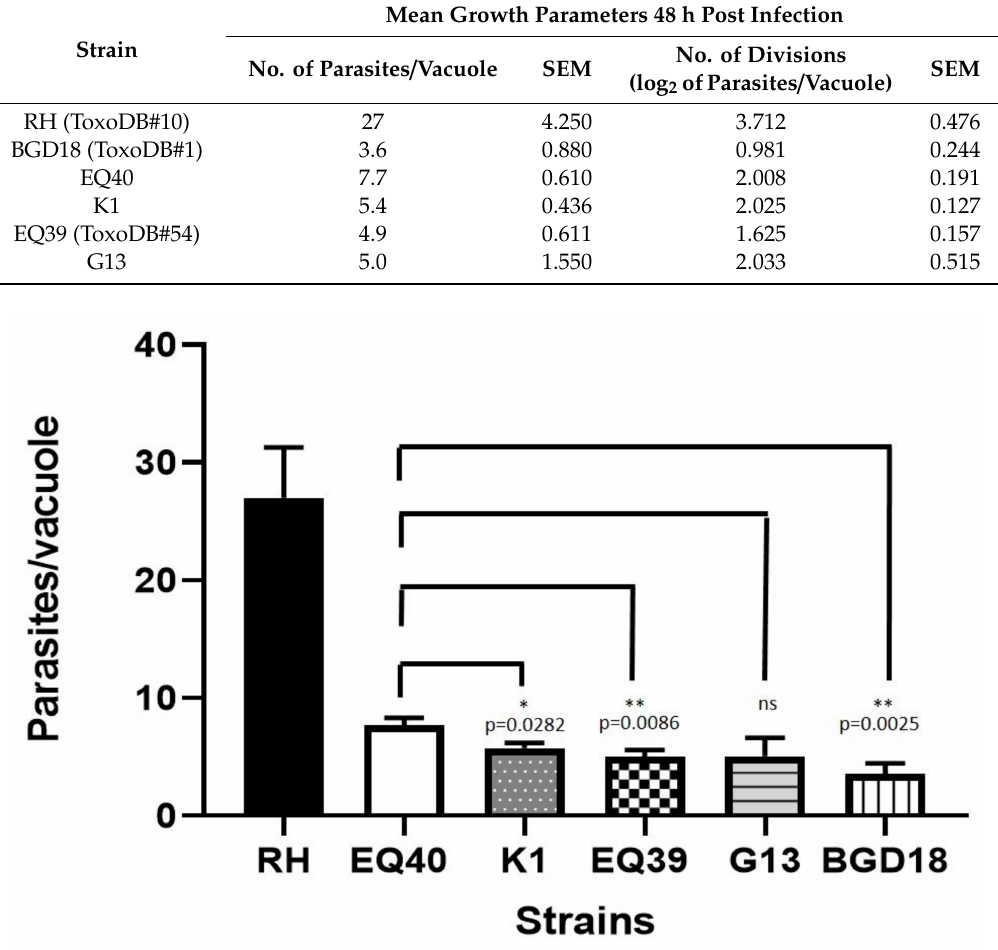
Figure 3. Mean vacuole loading after 48 h (* p < 0.05; ** p <